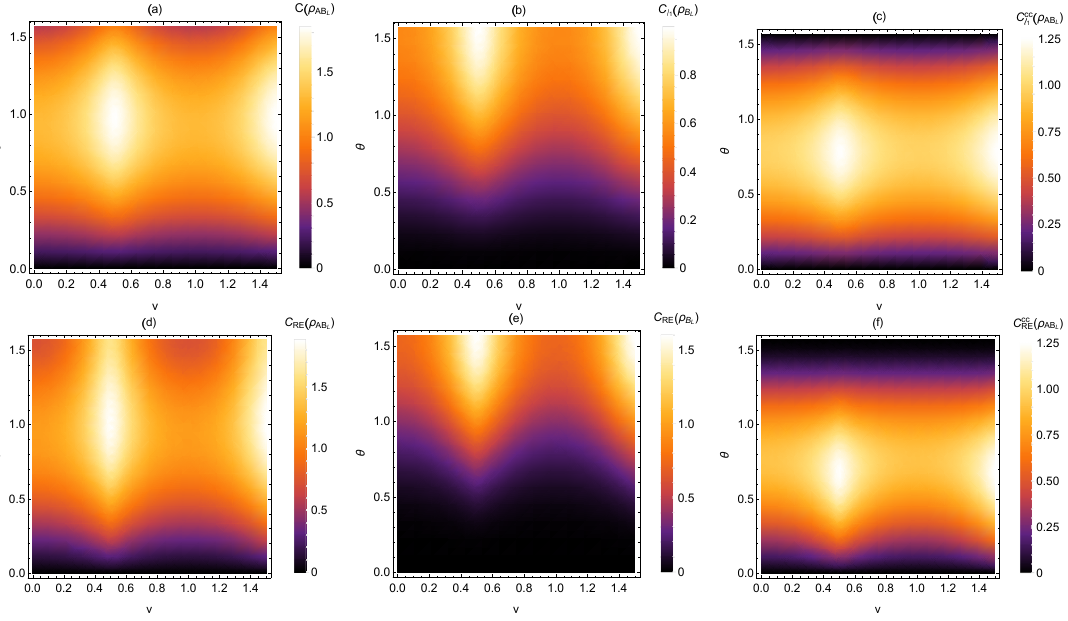
Figure 4 . The total coherence, local coherence and correlated coherence of state ρ AB of the mass parameter ν and the initial parameter θ . The curvature parameter p is fixed as p = 0